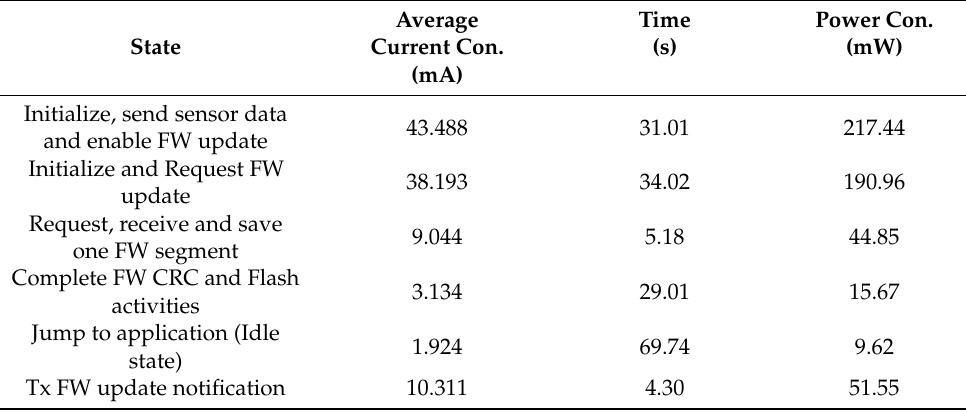
Table 3. Power consumption of device at V op = 5